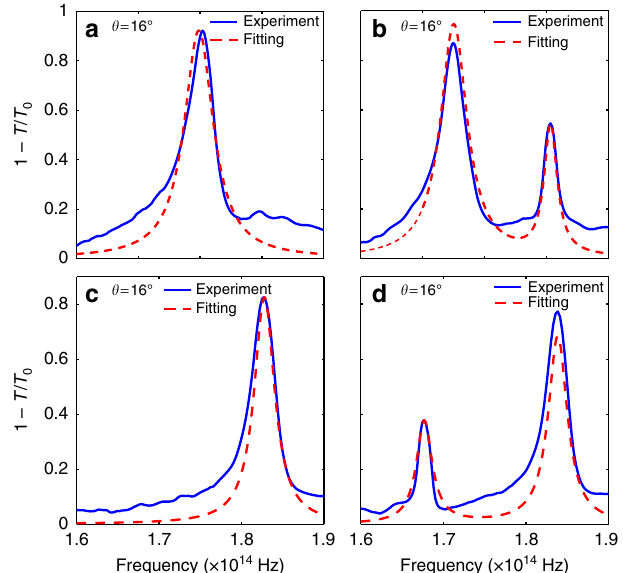
Fig. 3 Extraction of parameters of the effective Hamiltonian by fi tting. The experimental extinction spectra (1 − T / T 0 , where T 0 is the substrate transmittance) are fi tted by the analytical model Eq. (8) for a , b shrunken and c , d expanded structures with a / R = 3.15 and a / R = 2.85, respectively. Fitting for two different angles of incidence a , c θ = 0